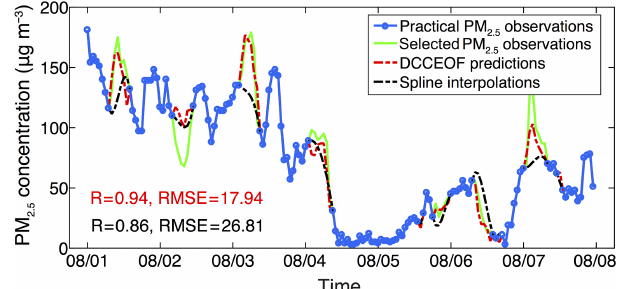
Figure 7. Comparison of predicted hourly PM 2 . 5 concentration val- ues between the suggested DCCEOF method and spline interpola- tion at the Wanshou Temple station in Beijing during the period of 1 to 7 August 2014 (time is given as MM/DD on the x axis). The green line shows the practical PM 2 . 5 observations that were selected to simulate data gaps, while their original values were retained for cross validation.